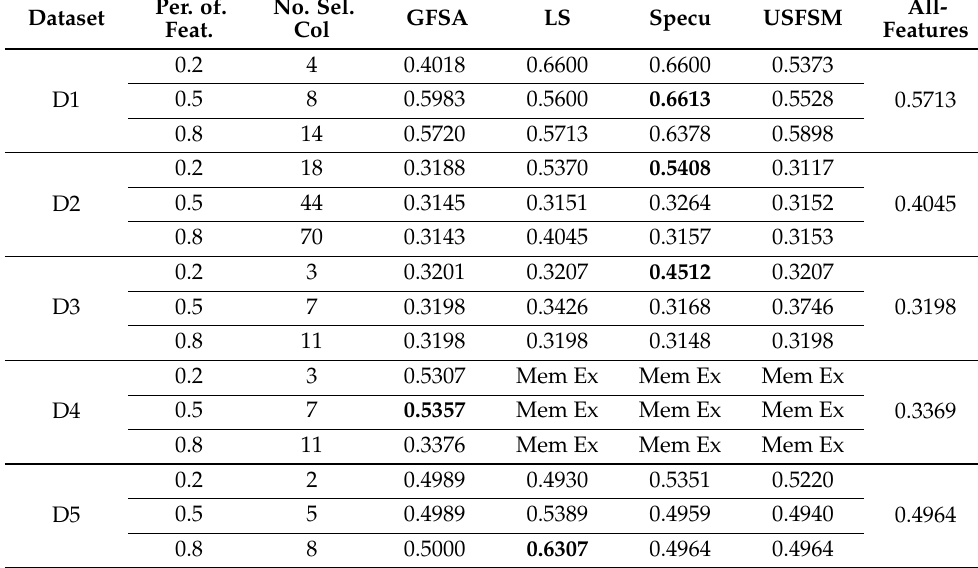
Table 2. Clustering accuracy where four feature selection (FS) methods were applied, showing results for three feature percentages versus all features. Highest FS-based result is in bold. Dataset